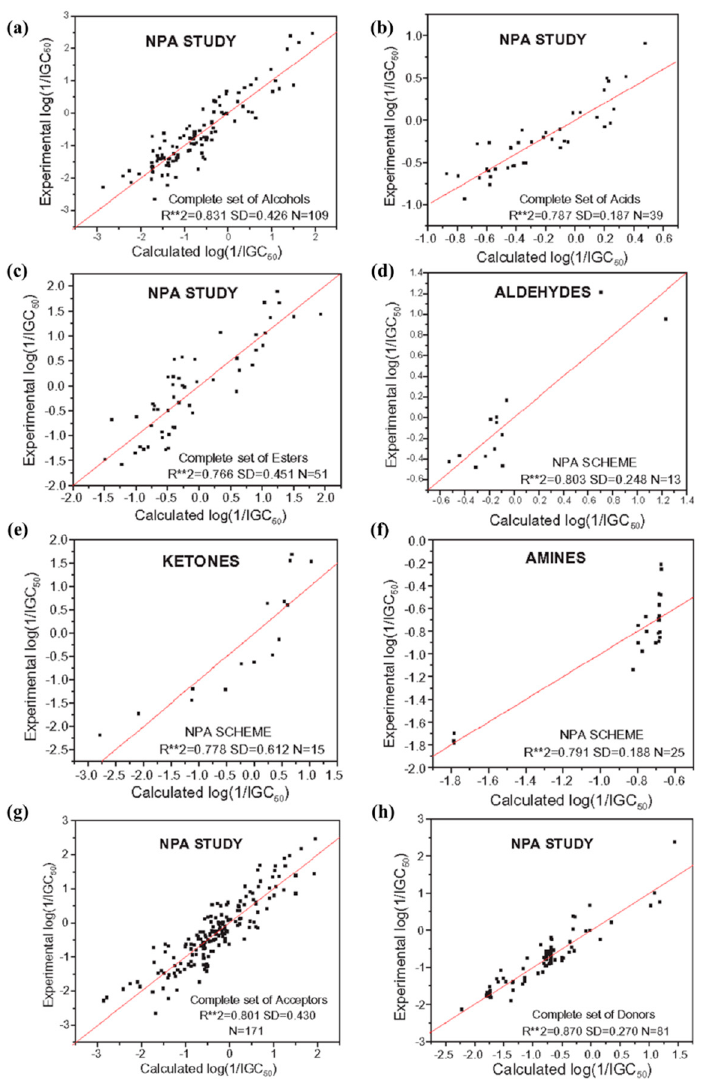
Figure 3. Correlation between the experimental and calculated log((IGC 50 ) − 1 ) of ( a ) alcohols, ( b ) esters, ( c ) acids, ( d ) aldehydes, ( e ) ketones, ( f ) amines, ( g ) all electron accepting compounds, and ( h ) all electron donating compounds (assorted from Ref. [78] Copyright © 2005 Elsevier Ltd.).